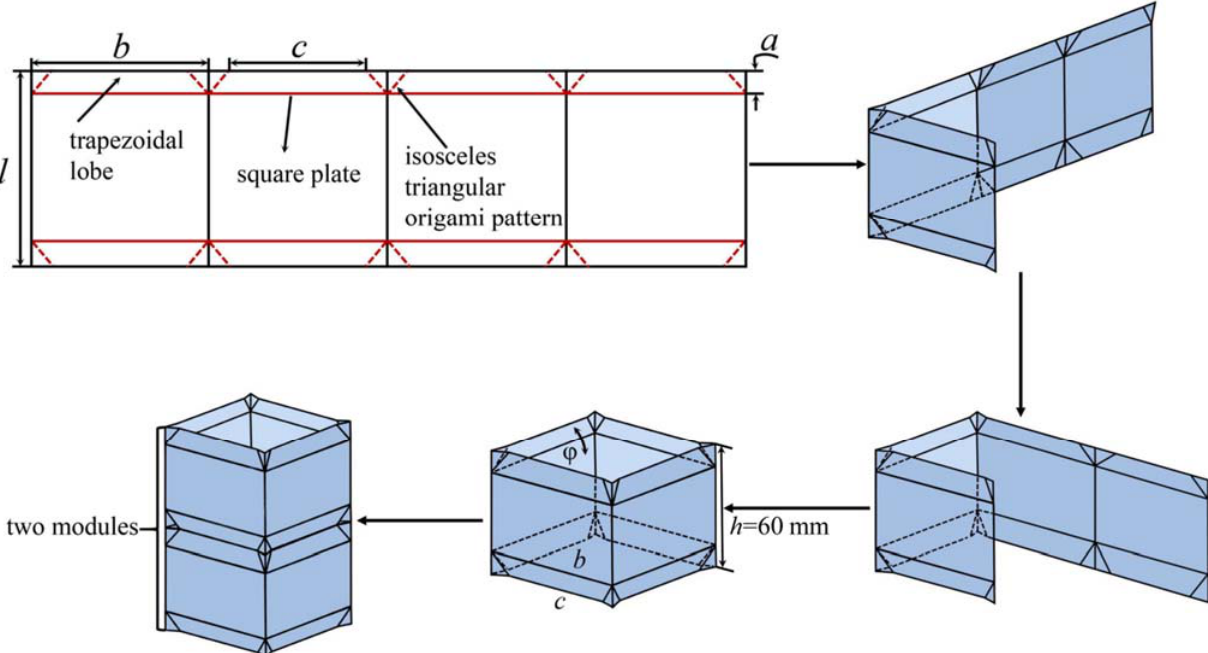
Figure 1. The traditional production process of OET.